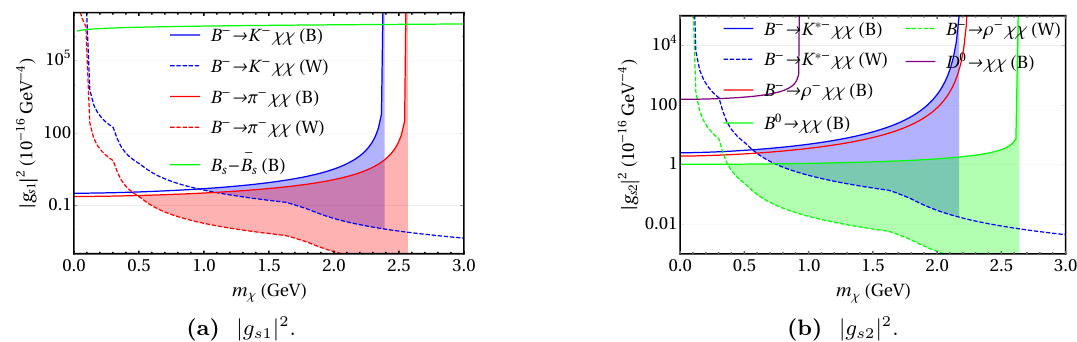
2 and 2 with di(cid:11)erent m g s 1 g s 2 j j j j